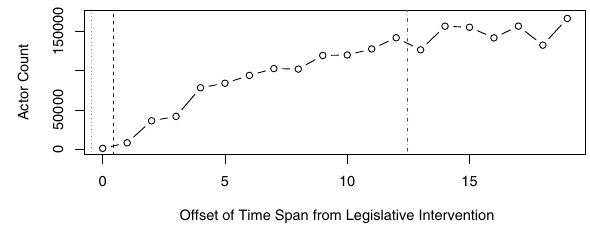
Fig. 12 In- and out-mean value exchanged per actor. Temporal representation of the mean value exchanged in cash-in transaction (circles) and the mean value exchanged in cash-out transaction (diamonds) for 30- day spans. The mean value exchanged in cash-in transactions per actor (2,657 agents) is around $276 and in growing over time. The mean value exchanged in cash-out transaction per actor (13,070 agents) is $128.